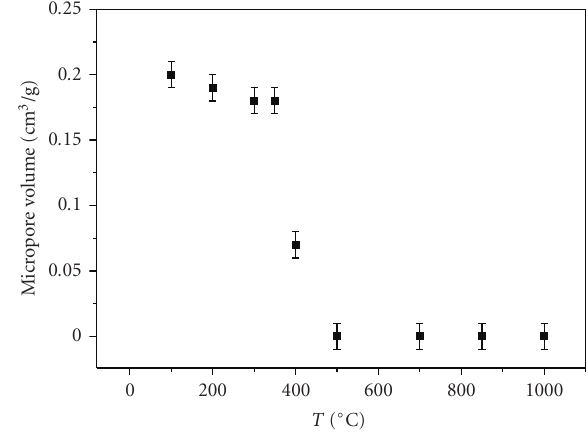
Figure 4: Micropore volume ( (cid:2) ) versus temperature of the thermal treatment of the samples.